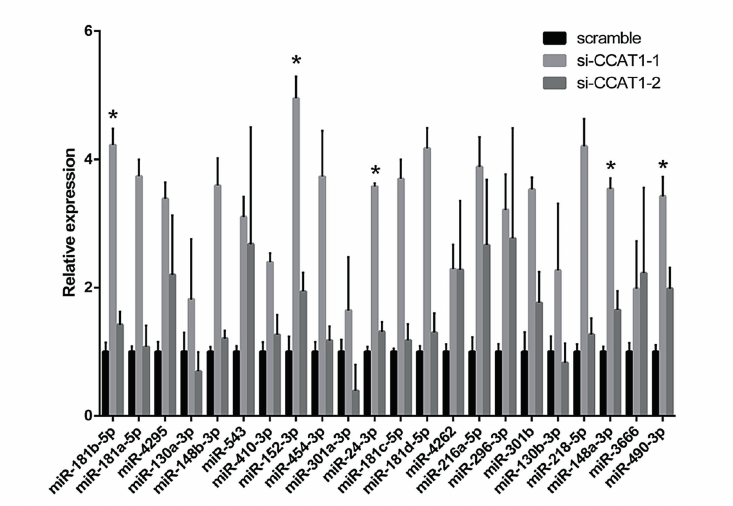
Figure 5 - Differential expression levels of 22 miRNAs in T24 cells transfected with scramble, si-CCAT1-1 or